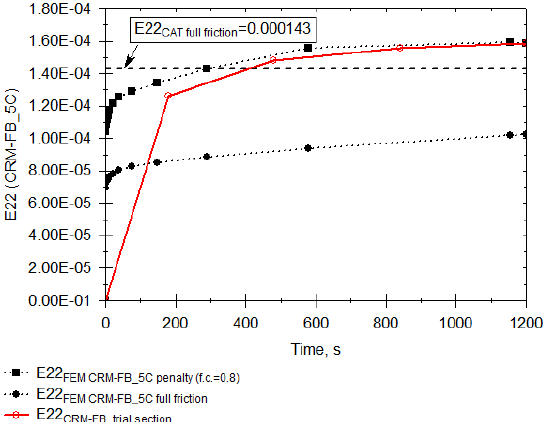
Figure 12. Distribution of the horizontal strain E22 in a time function under the vehicle’s wheel, underneath the CRM-FB_5C layer.